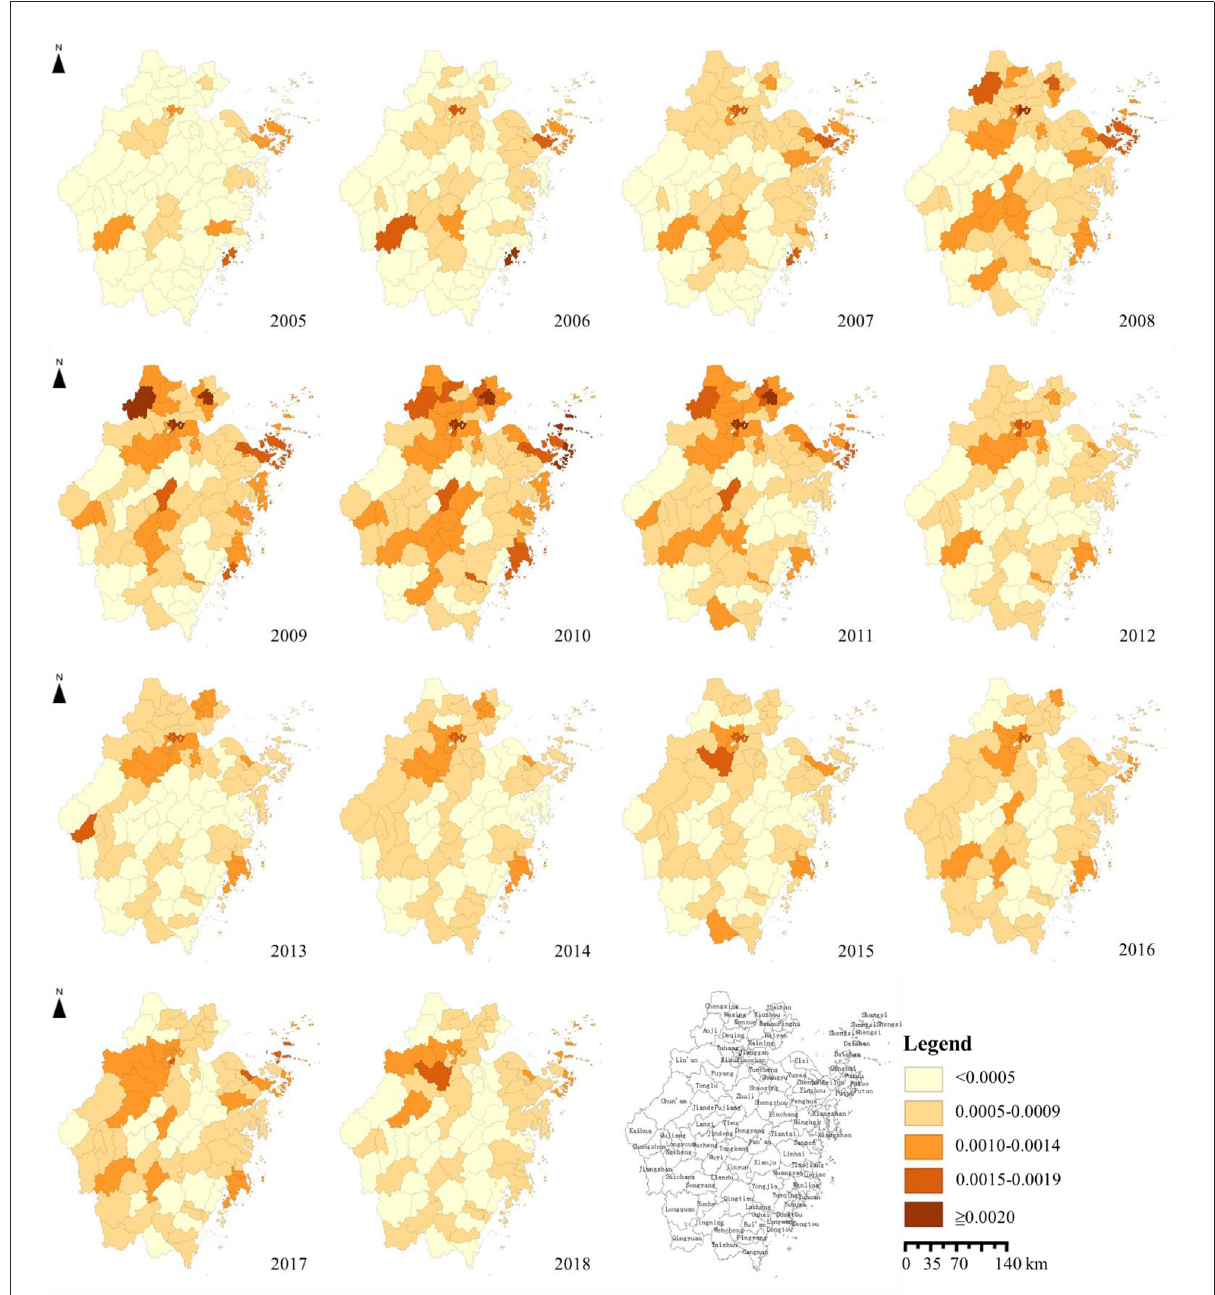
FIGURE3 Spatial distribution of reported incidence of syphilis in Zhejiang Province,